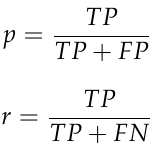
Figure 7. Scale distribution of targets.